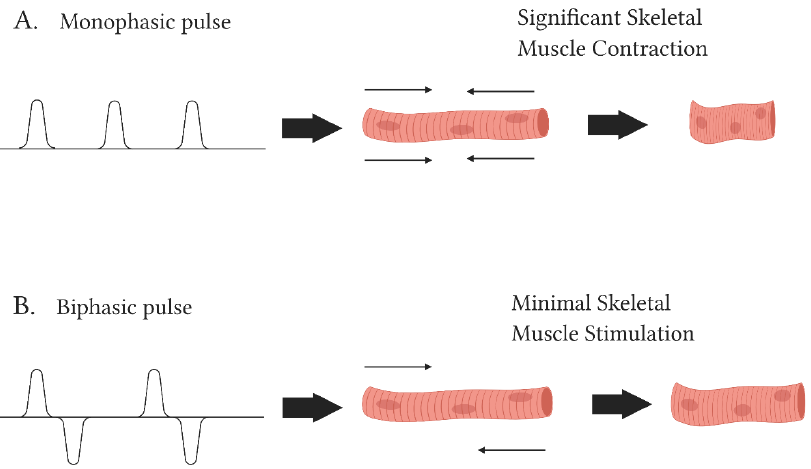
Figure 3. Structure of monophasic and biphasic pulses and their effect on muscle during ablation. ( A ) Monophasic pulses have been shown to induce excessive skeletal muscle spasm in patients thus requiring the use of general anaesthesia and paralytics. ( B ) Muscle activation induced by biphasic is minimal and therefore requires sedation.